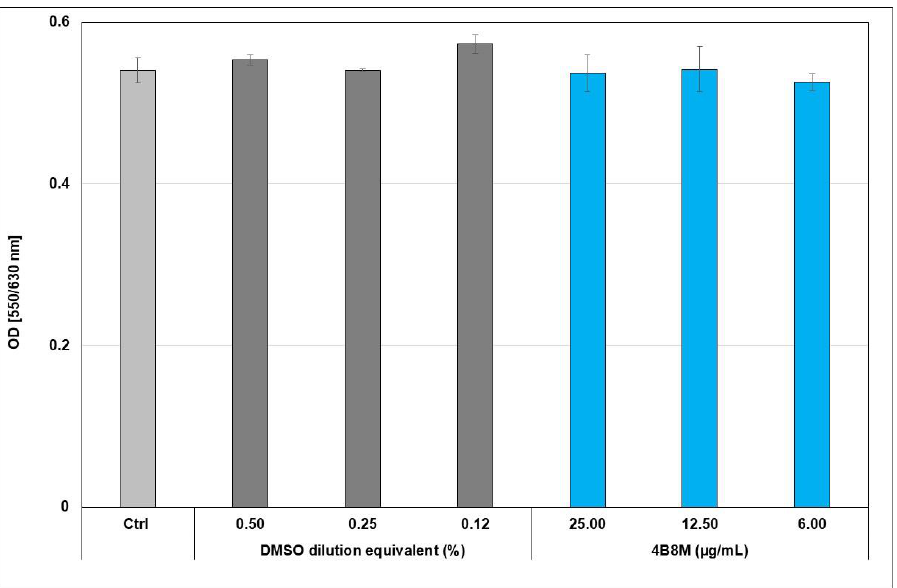
Figure 1. Toxicity of 4B8M against mouse splenocytes in comparison to related compounds. Splenocytes were cultured for 24 h with the compounds at indicated concentrations. Control cultures contained corresponding dilutions of the solvent (DMSO). Cell survival was determined by the MTT colorimetric method. The results of the cytotoxic tests are presented as mean values of optical density (OD) at 550/630 nm ± standard error (SE). * p < 0.05 as compared with appropriate DMSO controls.